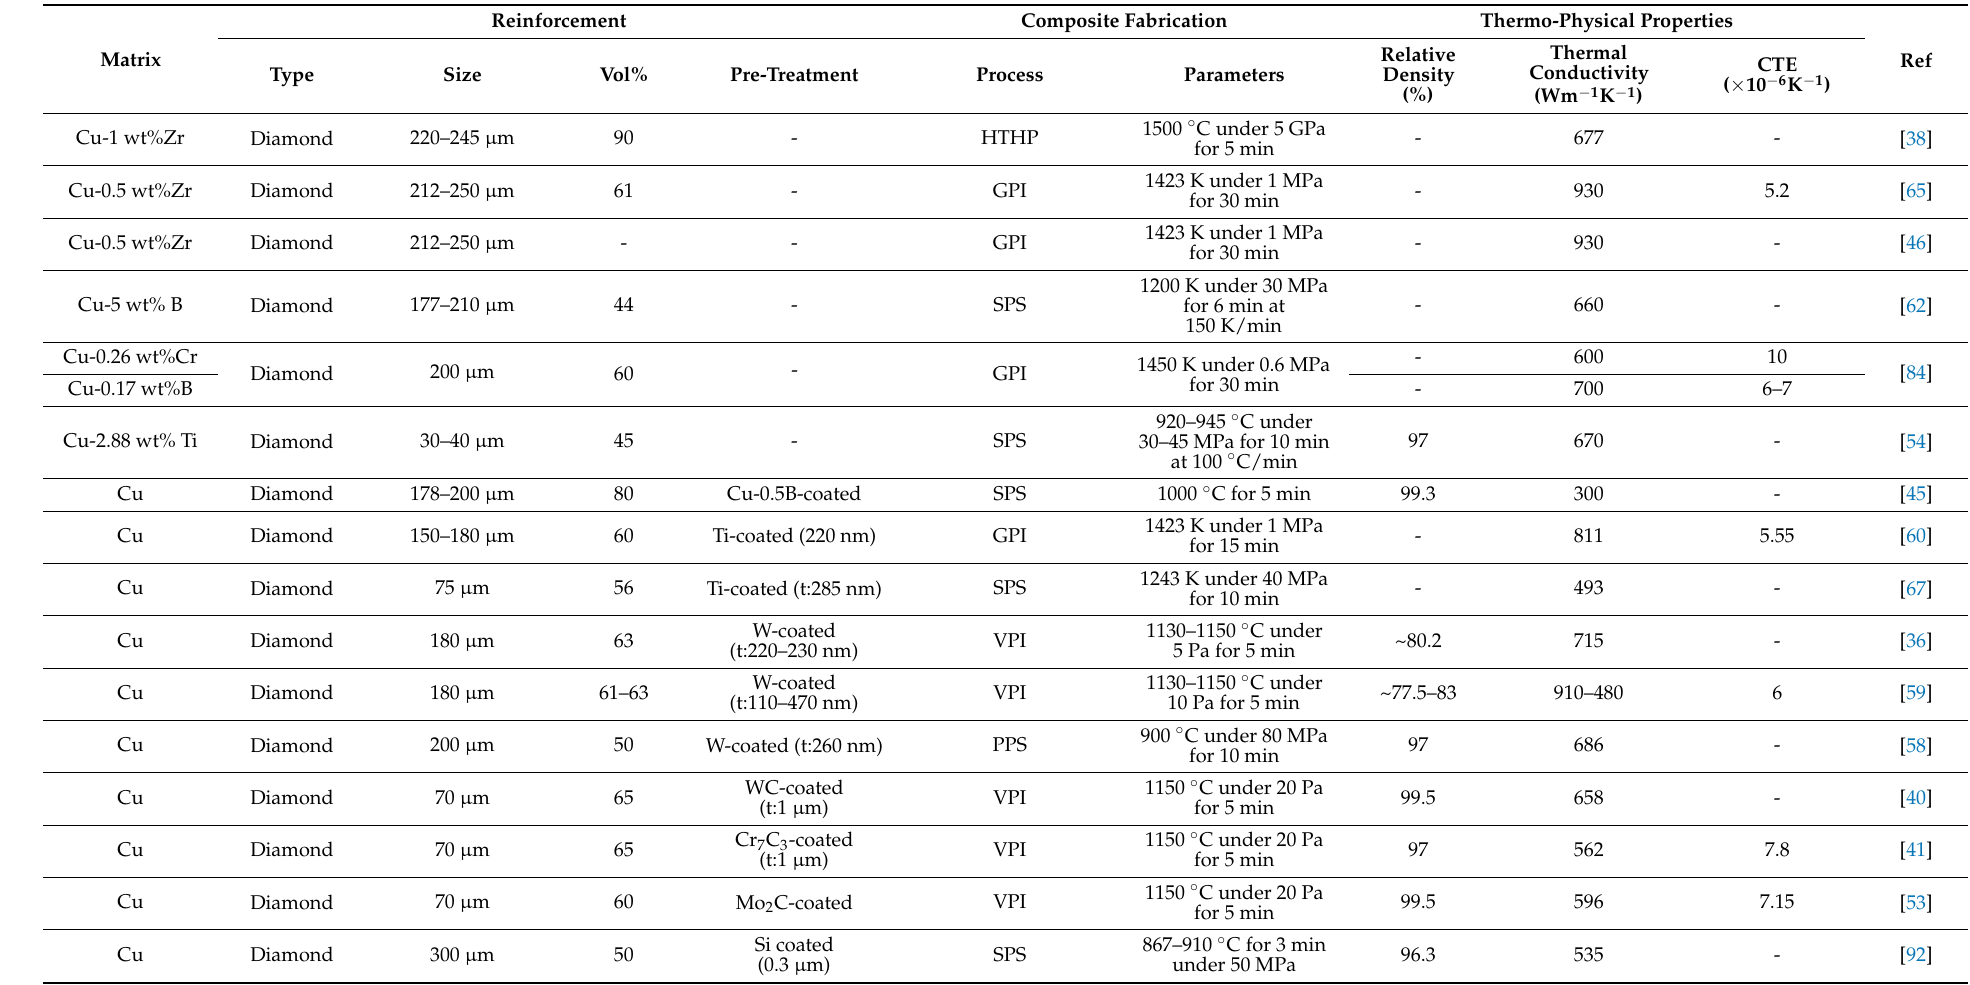
Table 1. Metal matrix composite in Heat Sink Application: Reinforcement, Processing, and